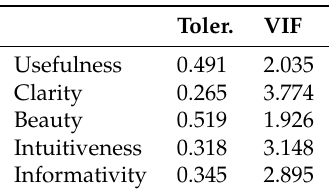
Table 3. Multicollinearity analysis. Note: VIF, variable inflation factor.